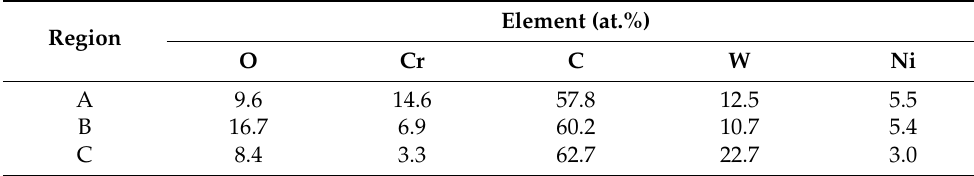
Table 3. Composition of elements in different regions of WC-Cr 3 C 2 -Ni coating after HAE for 6 h in 3.5 wt.% NaCl aqueous solution under different FVs and SCs. Element (at.%) Region O